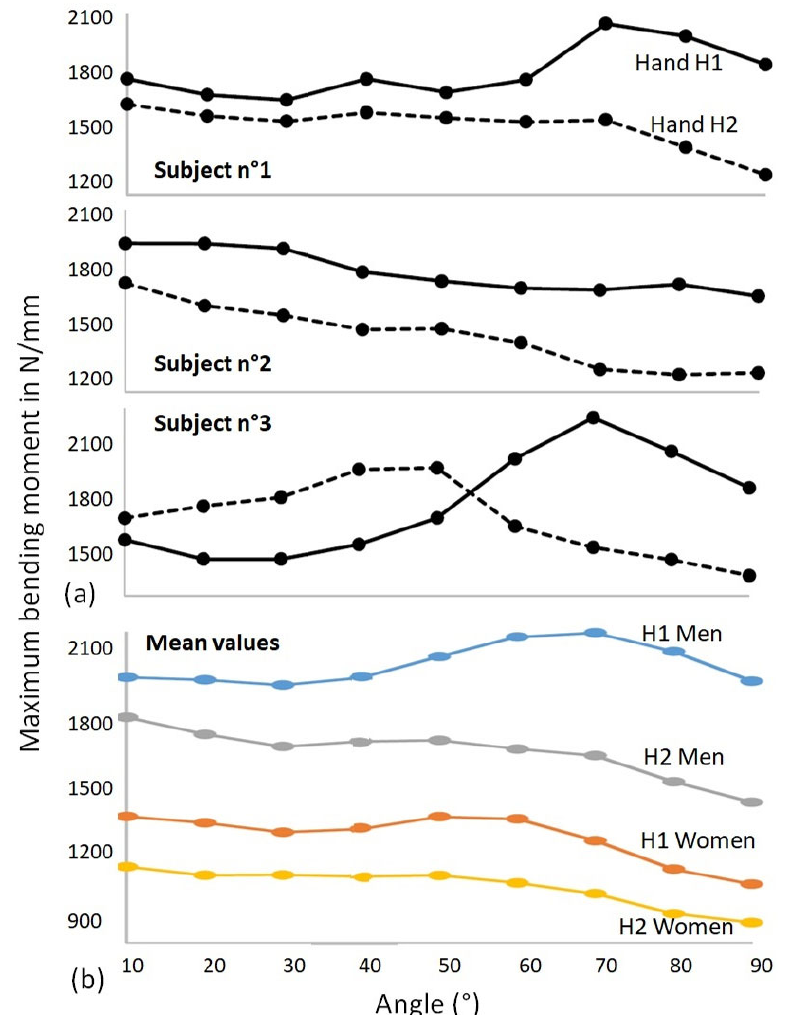
Figure 8. Evolution of the maximum bending moment as a function of the angular position for both hands H1 and H2 ( a ) for subjects n°1, 2 and 3; ( b ) mean values of the maximum bending moment for women and men.